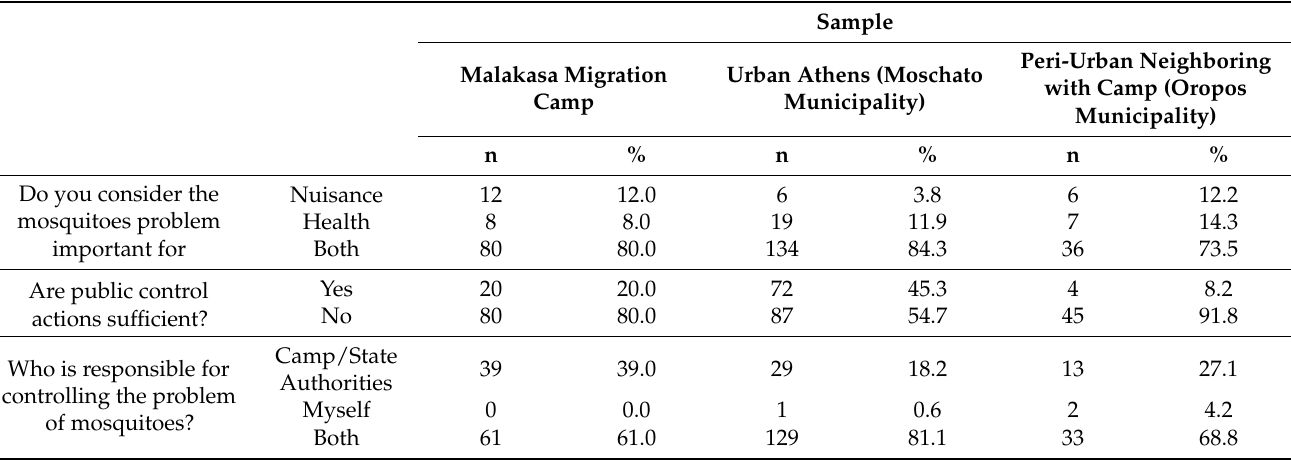
Table 5. Replies to questions related to public policy in the three sample